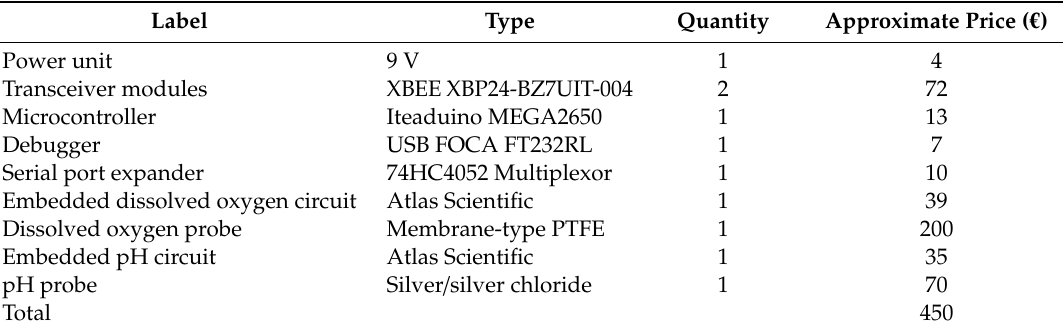
Table 3. Price list of each of the components